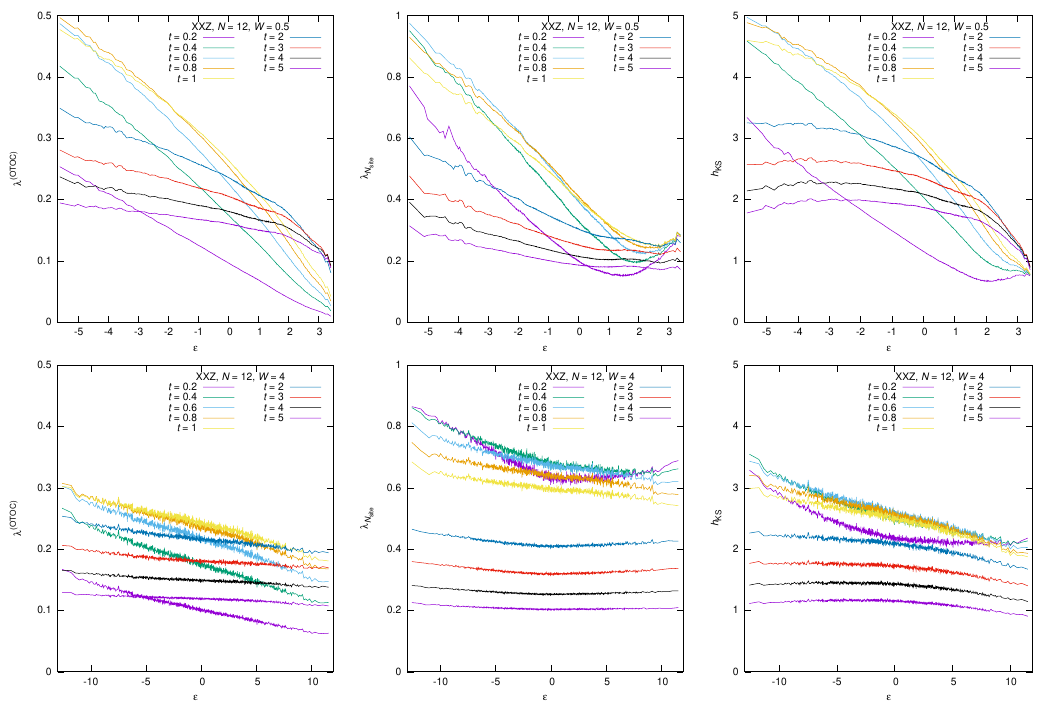
Figure 15 . For XXZ model, the dependence on the eigenstate energy of (cid:21) OTOC , (cid:21) N and h KS are plotted. For i = 1 ; 2 ; : : : ; 924, the sample average of these quantities for the eigenstate with the i -th smallest energy eigenvalue of the Hamiltonian is plotted against the average of the energy. Upper: W = 0 : 5. Lower: W =